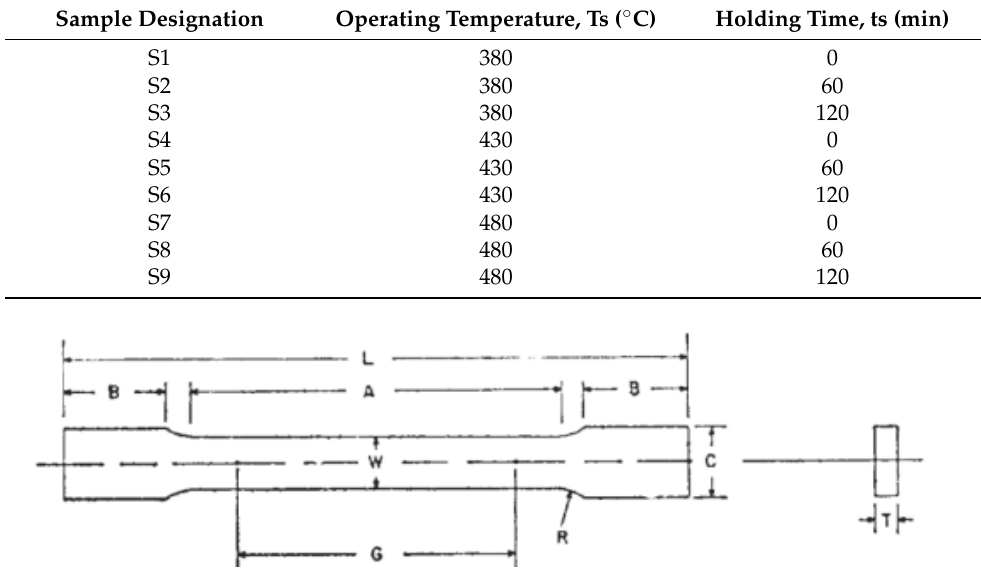
Table 2. The HPF process parameter for operating temperature and holding time.